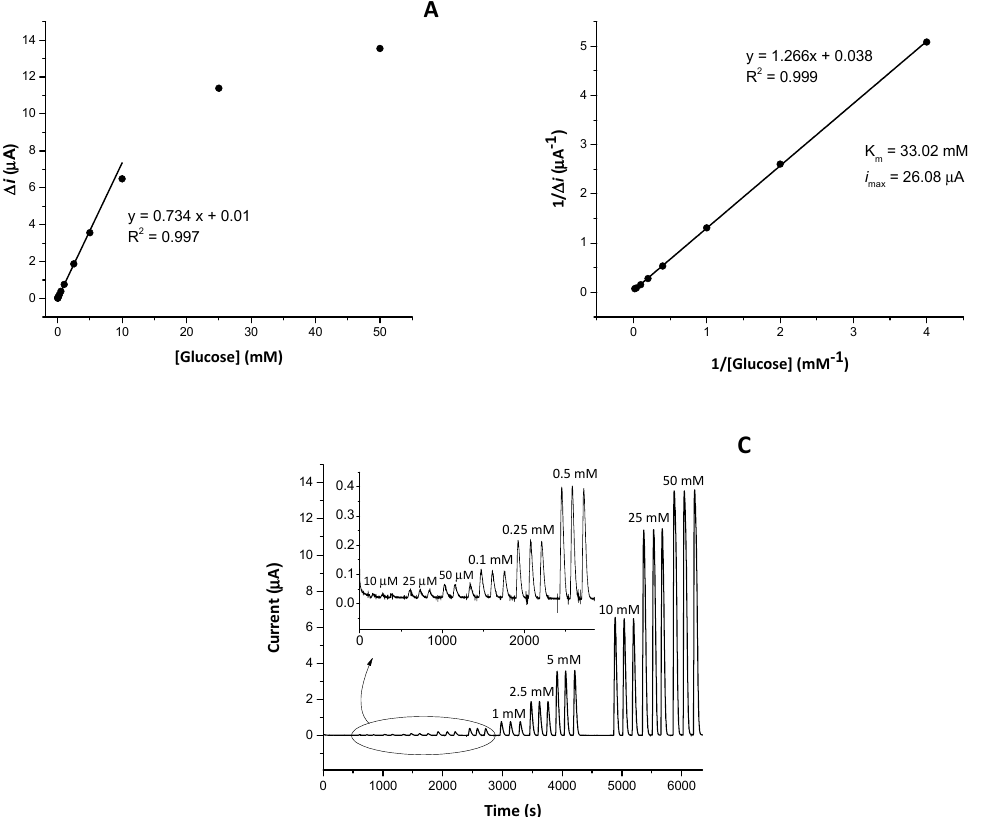
Figure 1. ( A ) Amperometric response of optimised Pt/PPD/GOx biosensor (50 U · mL − 1 , 30 cycles of CV)